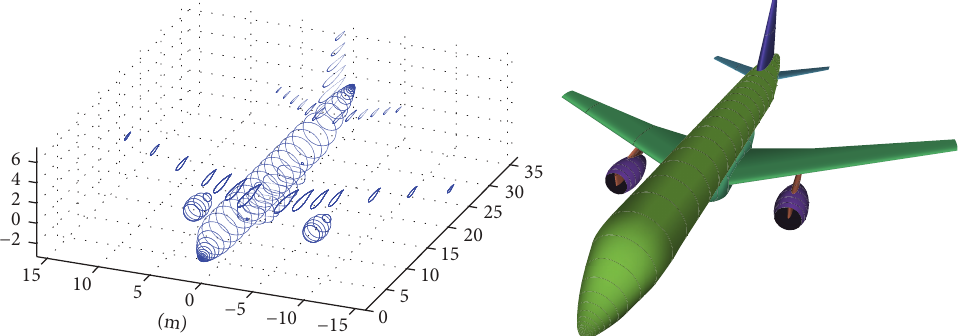
Figure 11: Parametric identification applied to the Reference Aircraft